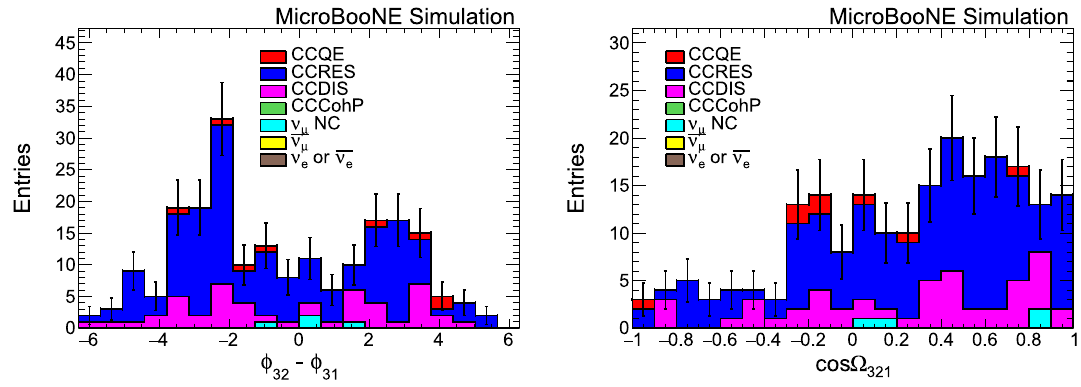
Fig. 37 Multiplicity = 3 φ 2 − φ 1 distribution (left); cosine of opening angle distribution between first and second track (right) from GENIE default MC. Black error bars represent MC statistical uncertainties